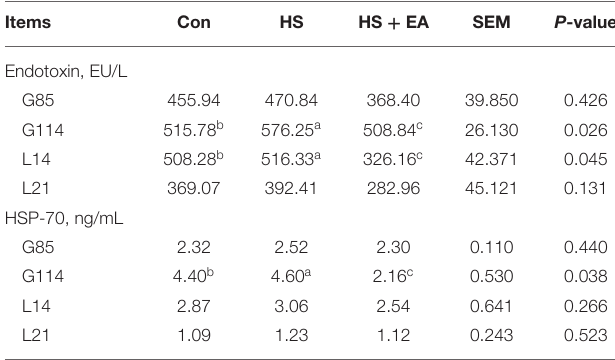
TABLE 3 | Effects of dietary EA supplementation on hormone levels in the serum of sows. Items